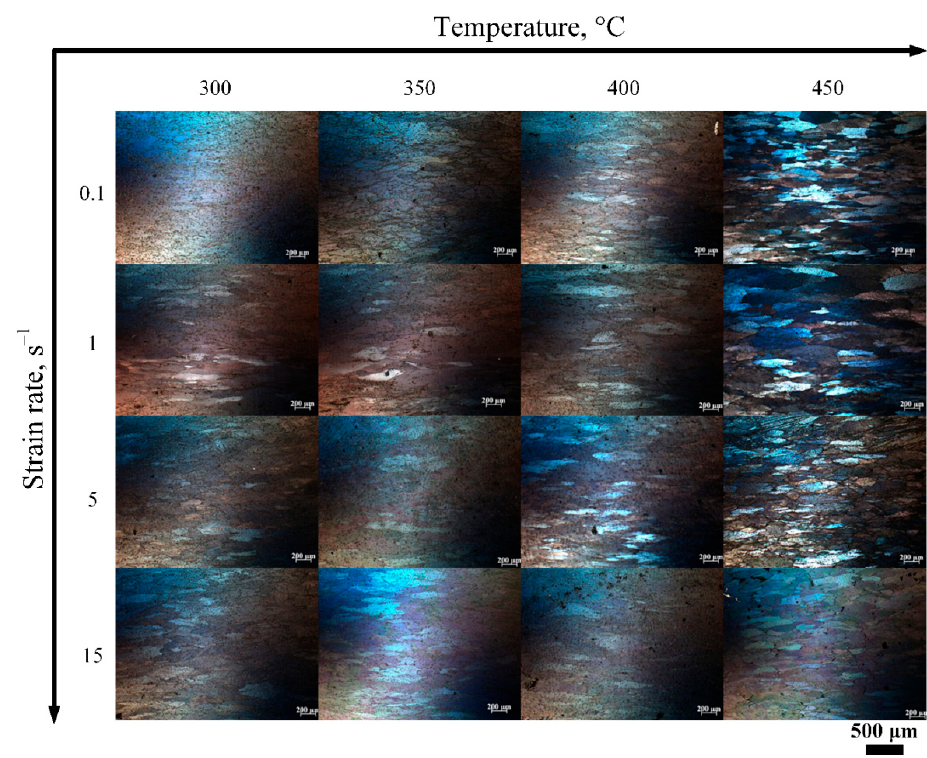
Figure 5. LM-images of the microstructures of the alloy 0.1Sc after deformation at different conditions.